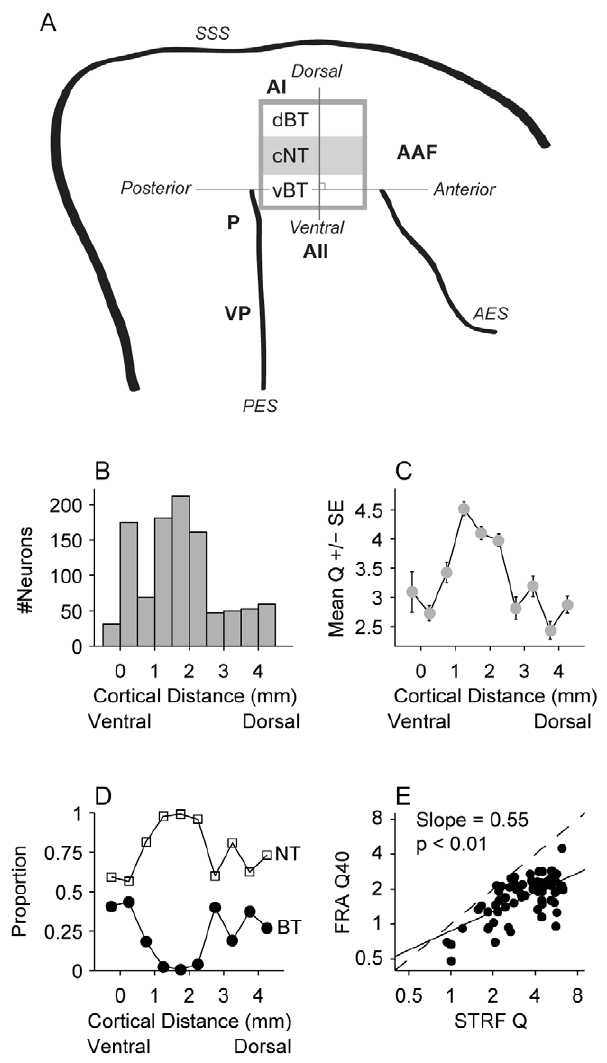
Figure 2. Recording location analysis. For each experiment, recording locations were noted on a digital photo of AI. Locations were estimated along the dorsal-ventral axis of AI by projecting the recording position onto a line that was orthogonal to a line connecting the tips of the anterior and posterior ectosylvian sulci. (A) Schematic of auditory cortex and spectral tuning modules. Rectangle in AI represents the region within AI where spectral tuning modules are present (dBT: dorsal broadband region; cNT: central narrowband region; vBT: ventral broadband region). Dorsal-ventral position of each electrode penetra- tion was calculated by projecting recording sites onto the line that is orthogonal to the line connecting the posterior ectosylvian (PES) and anterior ectosylvian sulcus (AES). SSS: suprasylvian sulcus. AAF: anterior auditory field; AII: secondary auditory field; P: posterior auditory field; VP: Ventral-posterior auditory field. (B) Number of recorded neurons along the dorsal-ventral axis. (C) Mean STRF Q values along the dorsal- ventral axis. Tuning is sharpest in the central region of AI. (D) For broadly tuned (BT) and narrowly tuned (NT) neurons, the proportion of each along the dorsal-ventral axis. BT neurons had STRF Q values , =1.5, and NT neurons had Q values . =3.5. Almost no BT neurons are found within the central region of AI. (E) Relation between STRF Q values and frequency response area (FRA) Q40 values. Dashed line represents equality, and solid line represents the best fit (slope=0.55, p , 0.01, t-test).